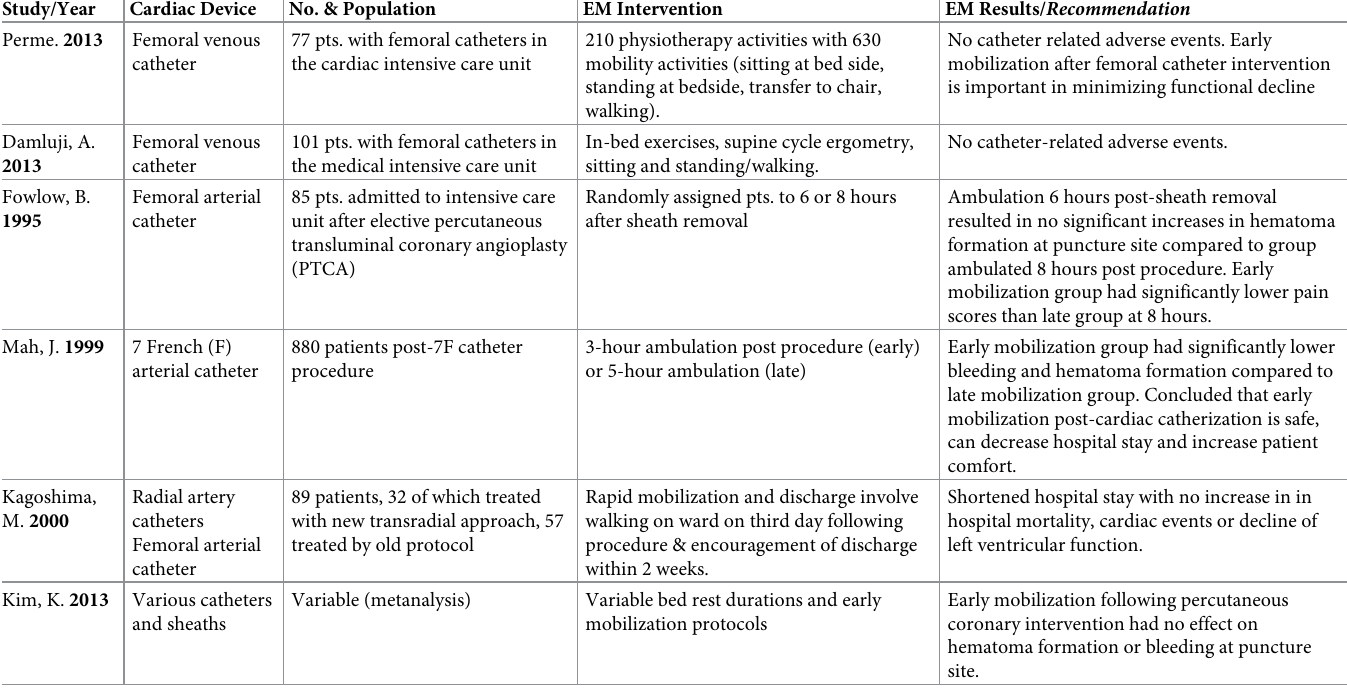
Table 3. Mobilization practices with cardiac